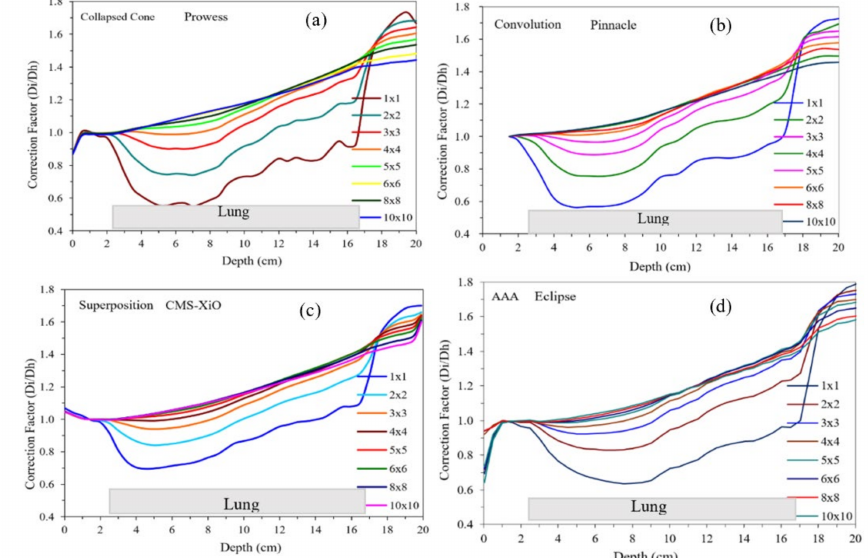
Figure 4. Calculated doses with different field sizes in a lung phantom using various - dose-calculation algorithms; ( a ) Collapsed Cone from Prowess, ( b ) Convolution from Pinnacle, ( c ) Superposition from CMS-XiO and ( d ) AAA from Eclipse. Please note the shape, pattern, and magnitude compared to Figure 3 for the pencil